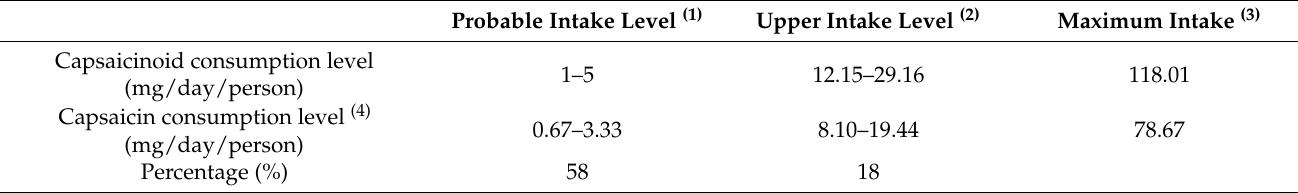
Table 3. Estimation of the probable capsaicinoid and capsaicin intake levels and upper intake